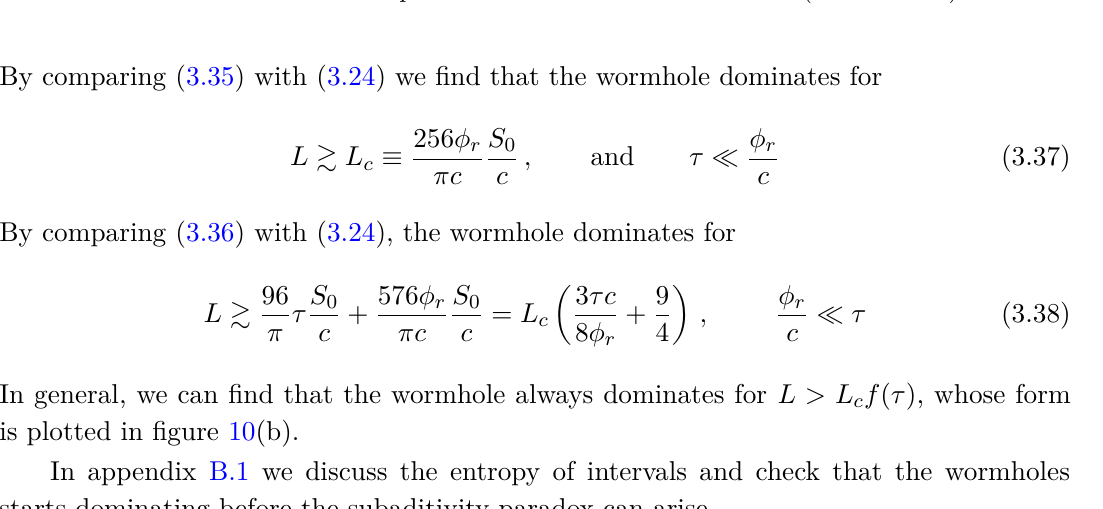
Figure 11 . When the region A is the entire spatial slice in the flat space region, we have an island that covers the entire throat or the spatial section of the FLRW universe (see section